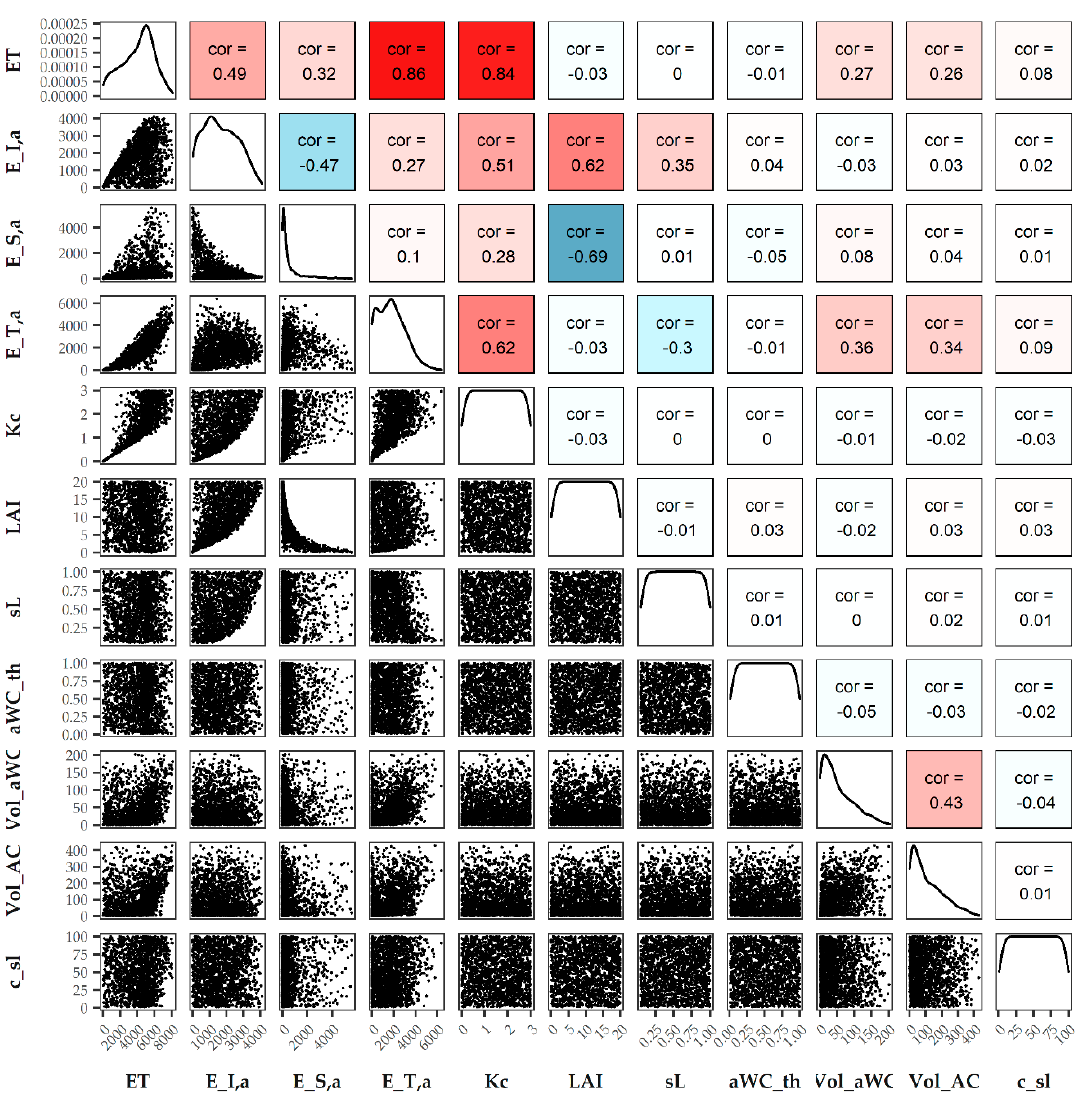
Figure 5. Results of LHS-simulations. Top: Pearson correlation coefficients 𝑐𝑜𝑟 , bottom: scatter plots in which each dot represents a parameter sample. Abbreviations for parameters are mentioned in Table 5.